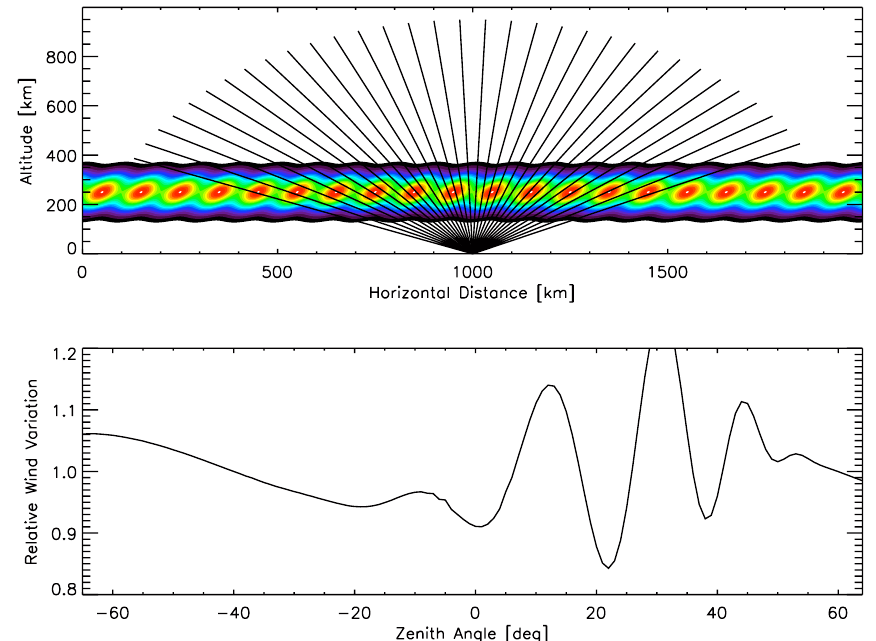
Fig. 6. Based on the gravity wave structures presented in Oliver et al. (1994), a model reconstruction of the measured horizontal wind field as a function of line-of-sight. (top) A spatial construct of the viewing geometry, with horizontal distance in the x-axis and altitude in the z-axis. The sum of the mean wind field and the gravity wave wind field ( ∼ 200-km vertical wavelength, ground-based period of ∼ 1-h, amplitude of ∼ 20% of the mean background wind), weighted by the vertical emission intensity profile, is depicted in color with each line representing a different FPI line-of-sight. (bottom) The relative variation of the measured wind speed as a function of the line-of-sight zenith angle (i.e., a value of “1” indicates a measurement that is equal to the true mean background wind). Only at large or negative (i.e., line-of-sights opposing the gravity wave phase structure) zenith angles would the impact of the gravity wave variation on the measured horizontal wind be averaged out over the